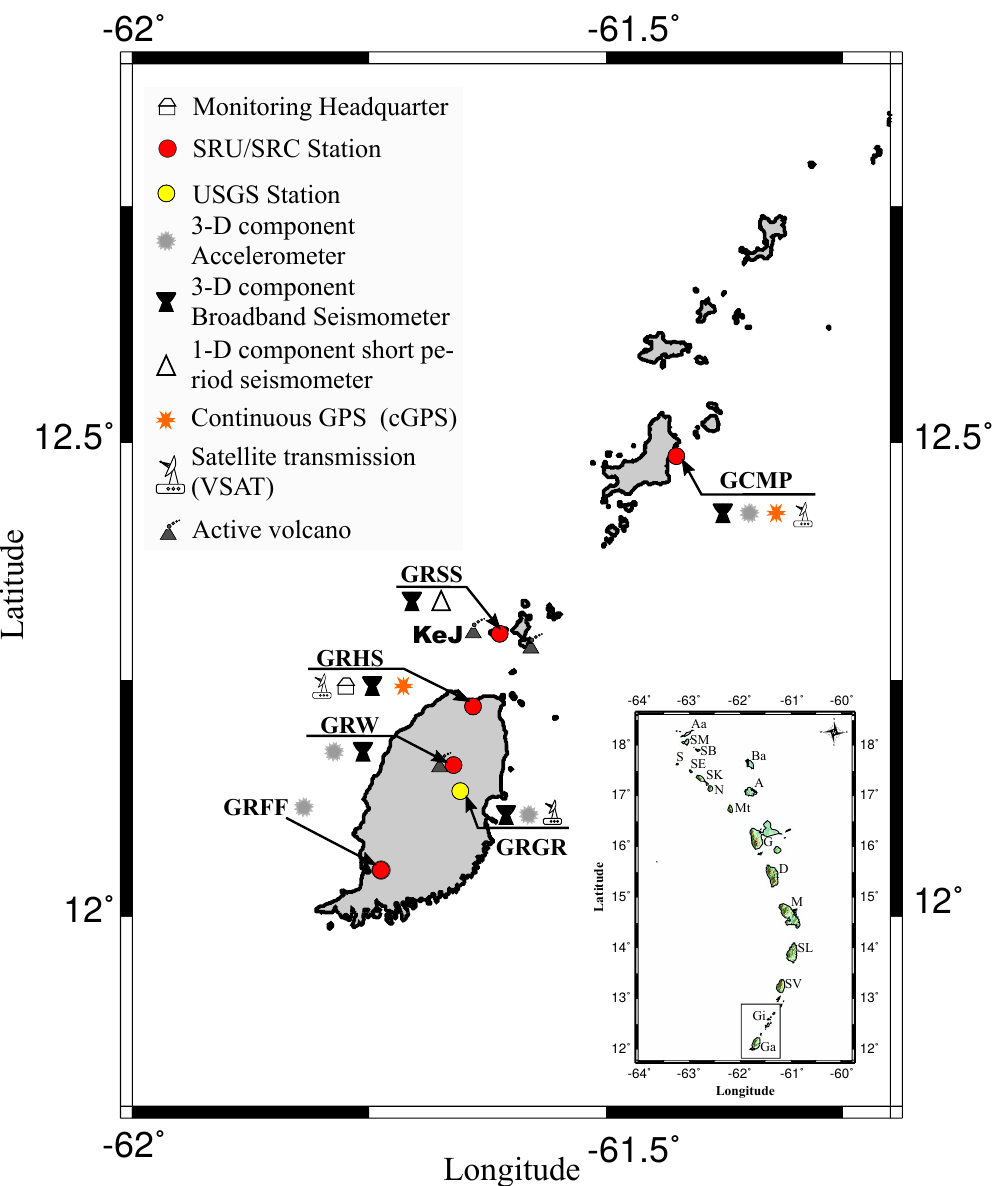
Figure 9. Map of an upgraded Grenada monitoring network with the addition of GRFF station at St Georges, the US Geological Survey (USGS)-owned GRGR station and a re-located Carriacou station (GCMP) in the year 2017. Inset: Antigua (A); Anguilla (Aa); Barbuda (Ba); Carriacou (Ca); Dominica (D); Guadeloupe archipelago (G); Grenada (Ga); Martinique (M); Montserrat (Mt); Nevis (N); Saba (S); St Bart (SB); St Eustatius (SE); St Kitts (SK); Saint Lucia (SL); St Marteen (SM); St Vincent